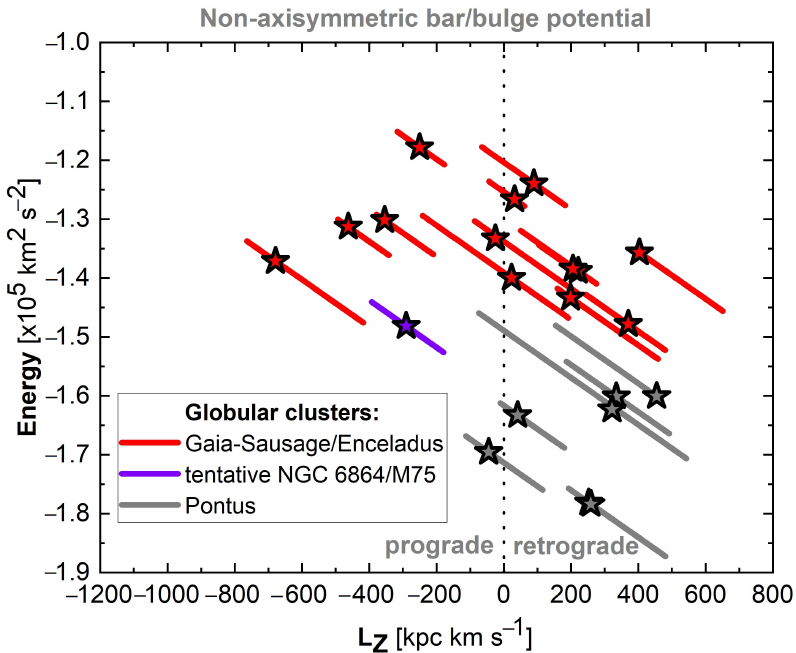
Figure 5. Evolution of the globular clusters on the ( L z , E ) -plane for non-axisymmetric potential with the rotating bar. Asterisks mark the initial positions of the clusters in the L z , E -plane (red colour—GSE objects; grey—Pontus objects; purple—tentative NGC 6864/M 75 cluster). The lines show trajectories along which the globular clusters